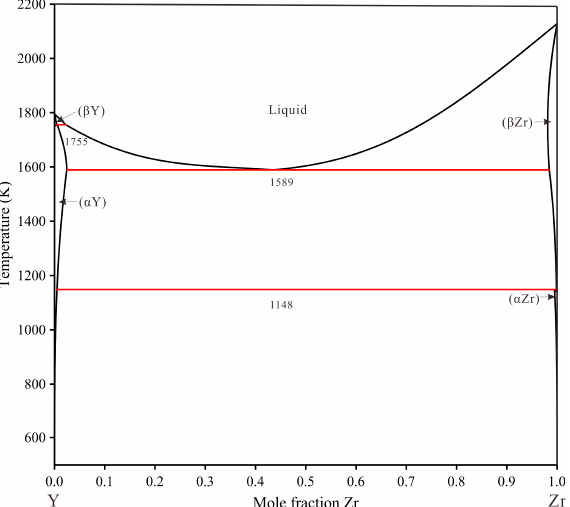
Figure 2. Calculated Cu–Zr phase diagram using the parameter from Liu et al. [21].